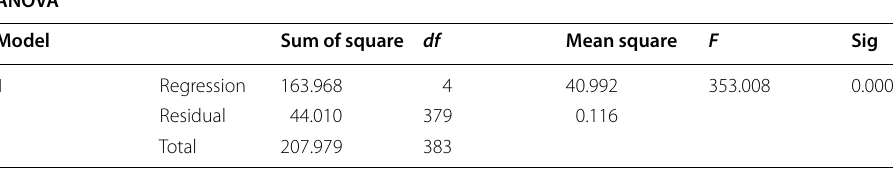
Table 4 Analysis of variance (ANOVA)